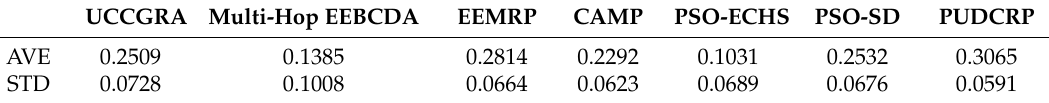
Table 3. Average and standard deviation of residual energy of nodes in the 500th round in the 400 m × 400 m network area (n = 200).